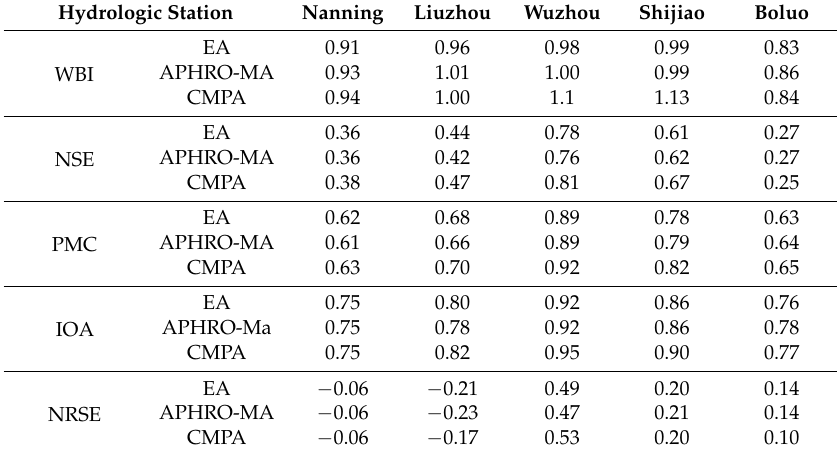
Table 2. Evaluation of the performance of the Coupled Land Surface and Hydrological Model System